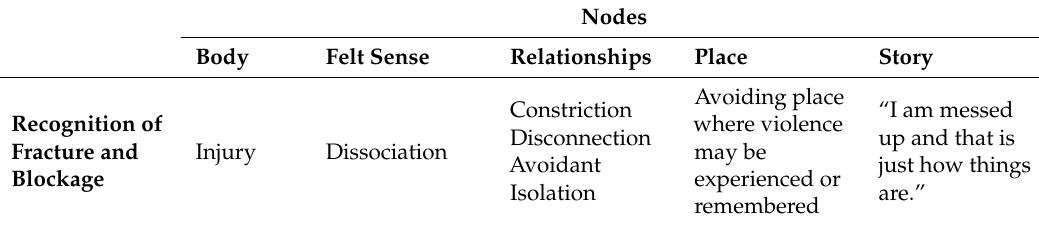
Table 2. Recognition of fracture and blockage associated with Post-Traumatic Stress Disorder.